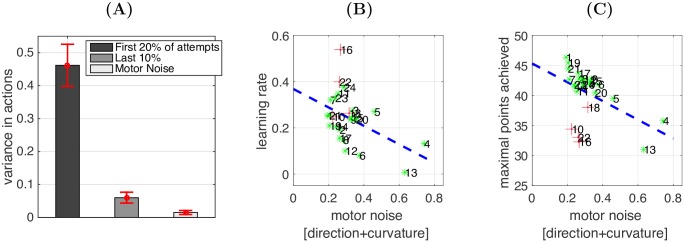
Exploration and motor noise.(A) How movement variance in the movements changes during the course of the learning process, compared with the variance observed in the motor noise task. (B) Learning rate and (C) maximal points achieved plotted against the variance observed in the motor noise task across participants (x-axis). Each dot represents one participant, indexed with the participant ID; Red crosses in (C) are the participants who failed to explore the curvature dimension (concentrated on straight movements with little curvature) and were identified as outliers. The least-squares line (blue dash line) is with the outliers removed.